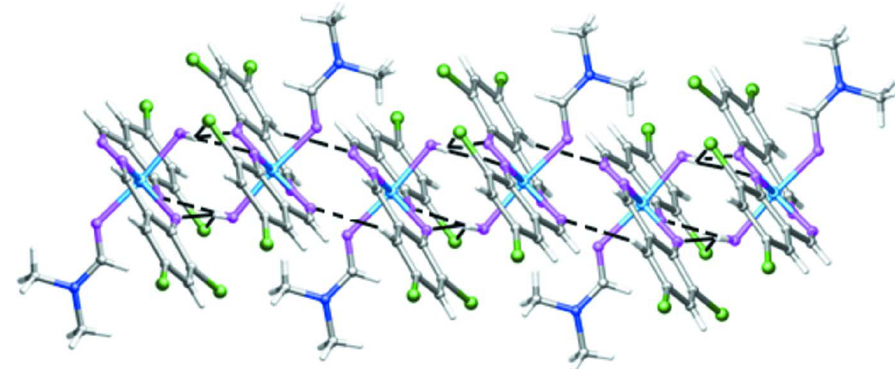
Figure 3 1-D chain of (I), Dashed lines indicate hydrogen bonds. cis-Aquabis(2,4-dichloro-6-formylphenolato- κ 2 O,O ′ )(N,N-dimethylformamide- κ